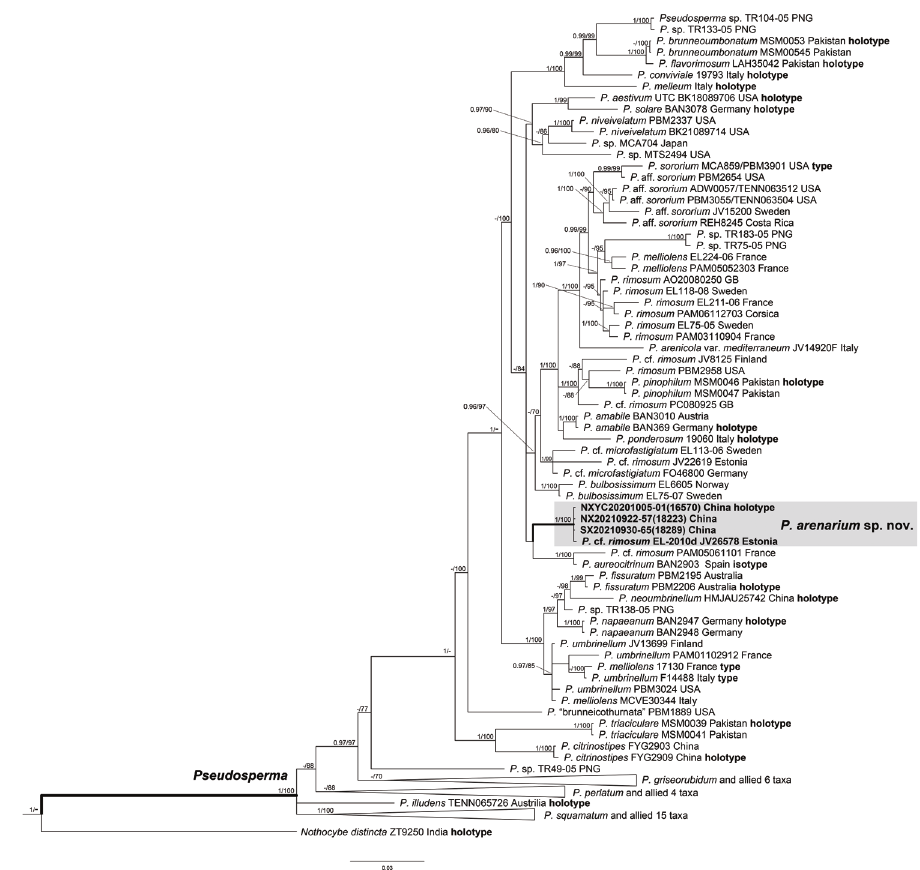
Figure 1. Phylogram generated by Bayes Inference (BI) analysis, based on a combined sequences dataset from nuclear genes (rDNA-ITS, nrLSU and rpb2 ), rooted with Mallocybe terrigena (Pruned). Bayesian Inference posterior probabilities (BI-PP) ≥ 0.95 and ML bootstrap proportions (ML-BP) ≥ 70 are repre- sented as